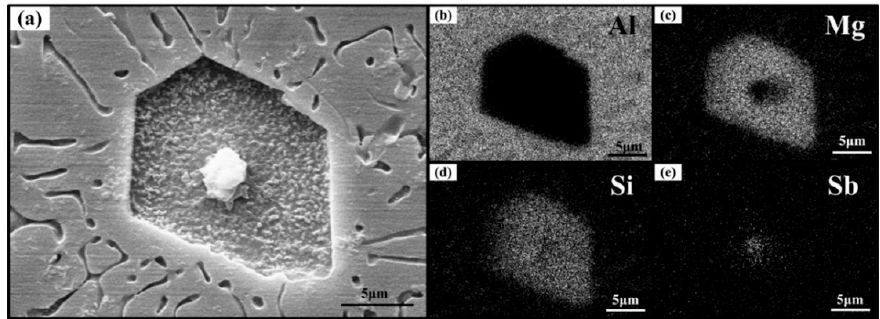
Figure 4. ( a ) The SEM micrograph and elemental surface scanning spectra for Al ‐ 20Mg 2 Si alloys modified with Li ‐ Sb for: ( b ) Al; ( c ) Mg; ( d ) Si; and ( e ) Sb.